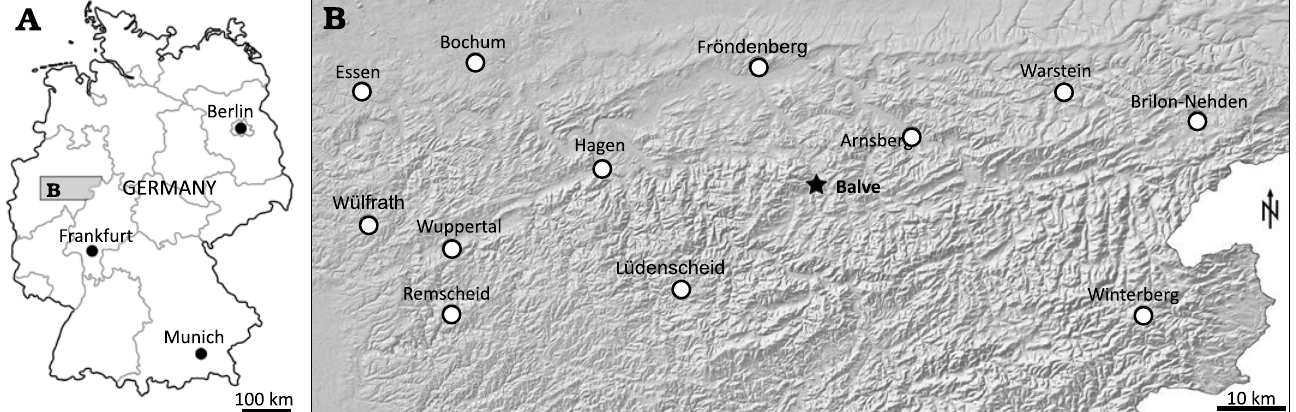
Fig. 1. Location of the Busche quarry near Balve in North Rhine-Westphalia (northwestern Germany). A . Map showing location of the northern Sauerland region of North Rhine-Westphalia in Germany. B . Map of the Sauerland region with topography, cities, and the Balve locality